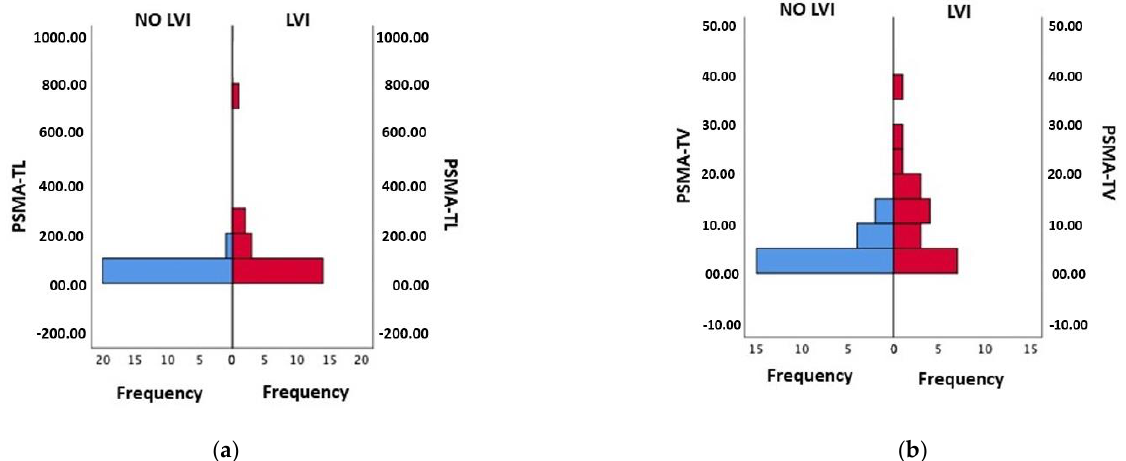
Figure 3. (a) Mann – Whitney Test for PSMA-TL and LVI (p-value 0.01); ( b ) Mann – Whitney Test for Figure 3. ( a ) Mann–Whitney Test for PSMA-TL and LVI ( p -value 0.01); ( b ) Mann–Whitney Test for PSM-TV and LVI (p-value 0.002) PSM-TV and LVI ( p -value